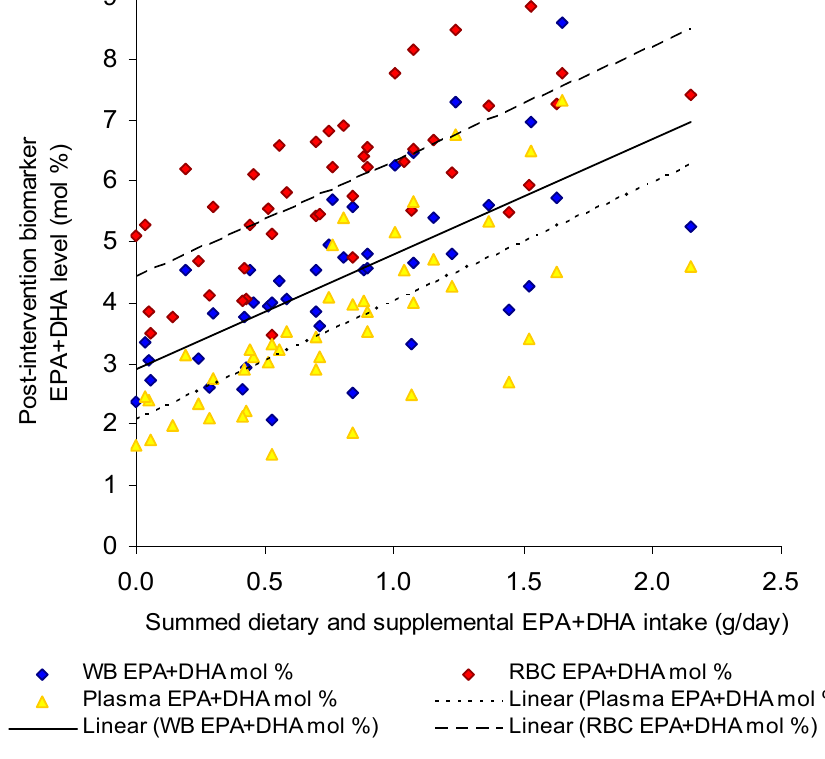
Figure 1. Scatterplot of individual summed dietary and supplemental intakes of EPA+DHA (g/day) and corresponding fingertip whole blood (R 2 = 0.52 p < 0.0001, n = 43), plasma (R 2 = 0.56 p < 0.0001, n = 45) and erythrocyte (R 2 = 0.56 p < 0.0001, n = 45) EPA+DHA levels at post-intervention (mol